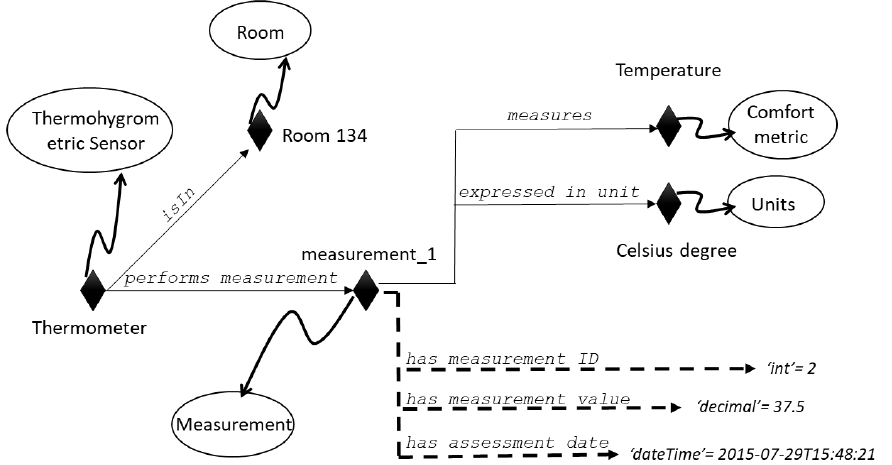
Figure 6. An example of the modelling of a measurement performed in the hotel room; individuals are represented with diamonds, concepts are represented with circles, and roles are represented with arrows (dashed arrows indicate datatype properties, full-line arrows represent object properties). The type of an individual is stated with a curved